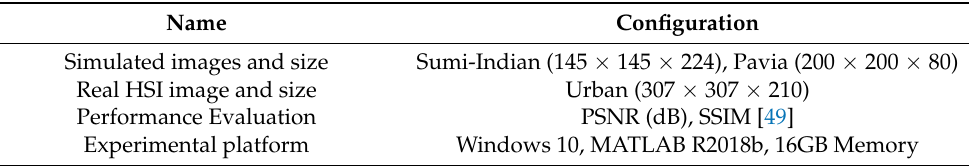
Table 1. Experimental environmental